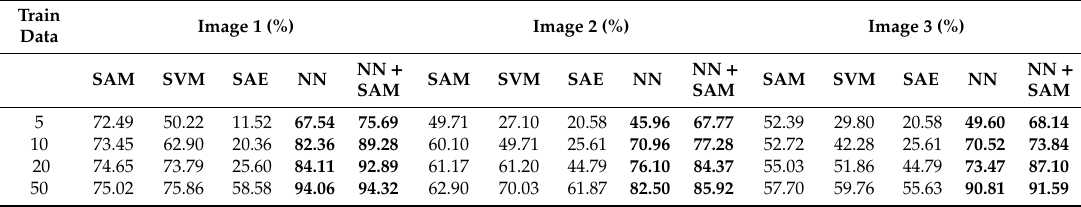
Table 2. Average classification accuracies for the first image set.